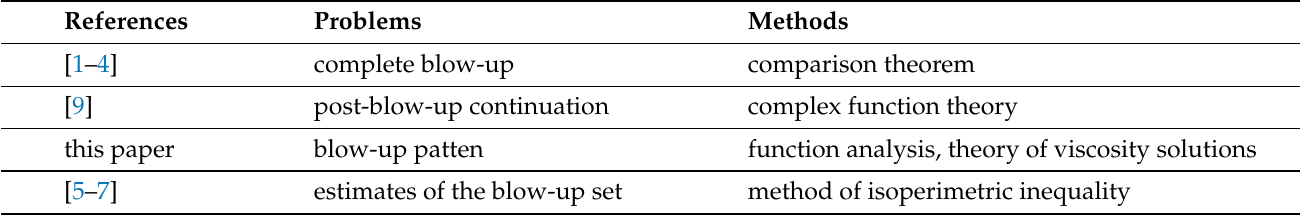
Table 1. Blow-up of the solution to semilinear parabolic